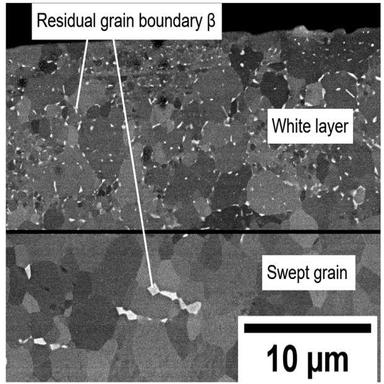
Cross-sectional backscattered SEM micrograph of un-etched sample 6 which had been heat-treated below the β-transus to result in grain growth.